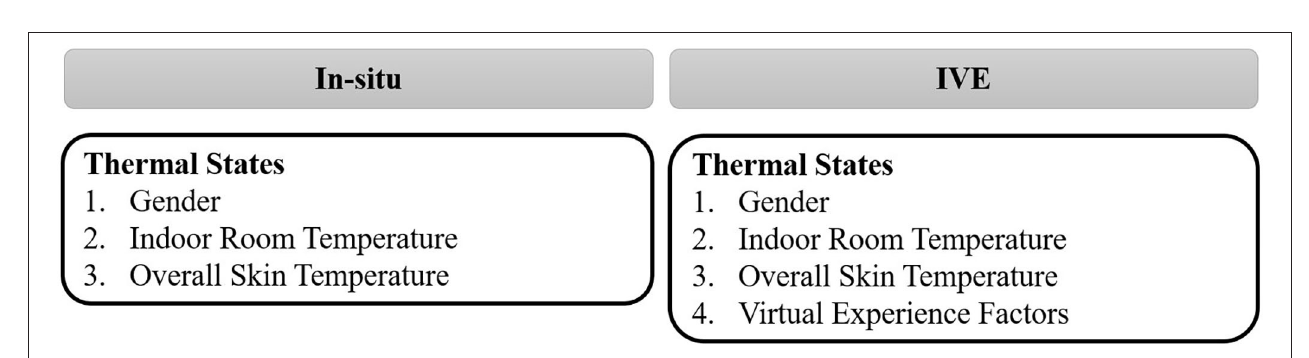
FIGURE 5 | Data segmentation and factor assignment for analyzing thermal states.